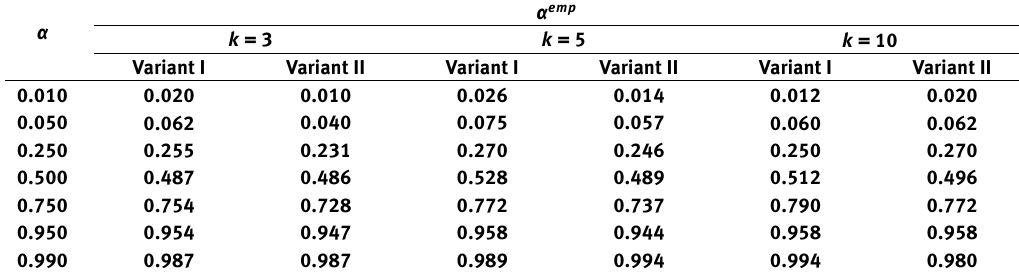
Table 3. Empirical significance levels α emp for